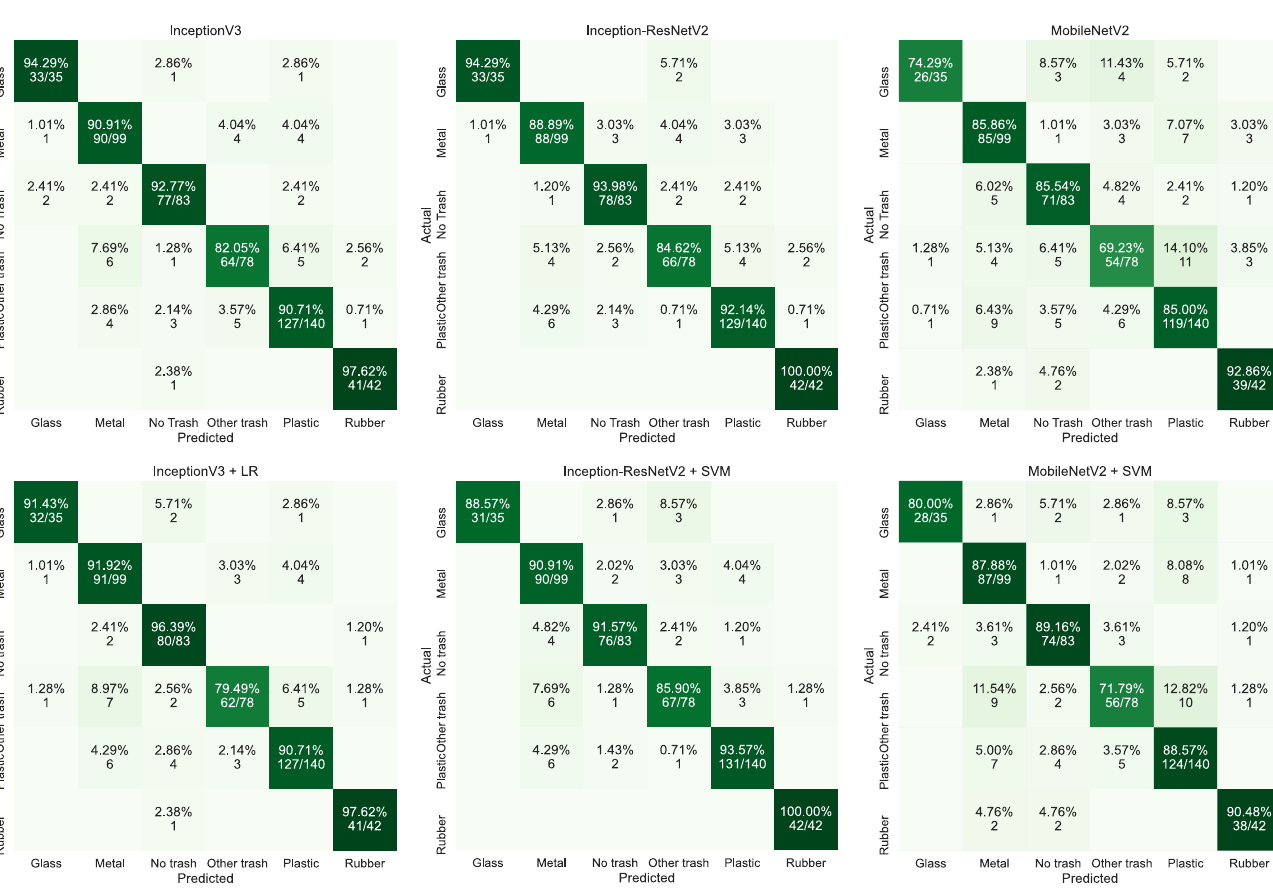
Figure 20. Normalized confusion matrices. Confusion matrices in the first row show predictions of NN classifiers with FT deep feature extractors, while those in the second row show predictions of the conventional ML classifier with the best performance on the test